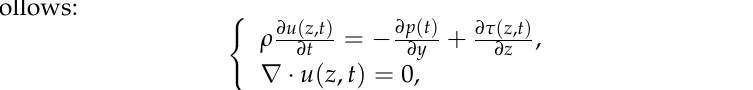
Figure 5. The flow problem: ( a ) parallel plates gap model; ( b ) typical velocity profiles of MR fluid in the activated and inactivated regions.